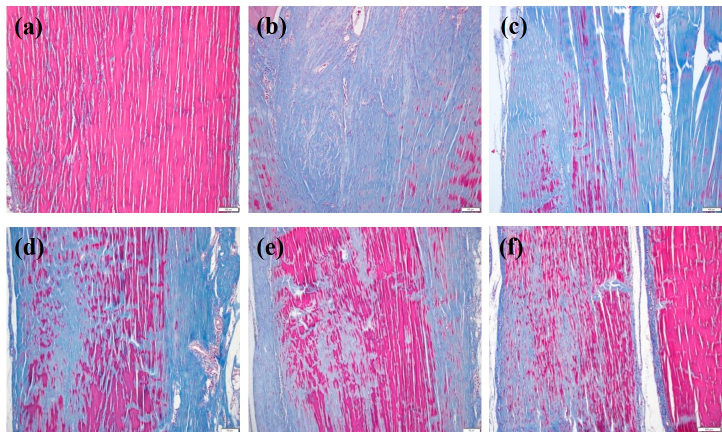
Figure 4. Masson’s trichrome staining at 7 weeks after collagenase (Col (I)) injection into tendon tissues, and at 6 weeks after treatment with PMSs, simvastatin, SIM (1 mM)/PMSs, and SIM (5 mM)/PMSs. Groups are categorized as follows: ( a ) control (no treatment); ( b ) Col (I); ( c ) Col (I) + PMSs; ( d ) Col (I) + simvastatin; ( e ) Col (I) + SIM (1 mM)/PMSs, and ( f ) Col (I) + SIM (5 mM)/PMSs. Scale bar: 100 μ m. Red: collagen fibers; Blue: collagen matrix breakdown.